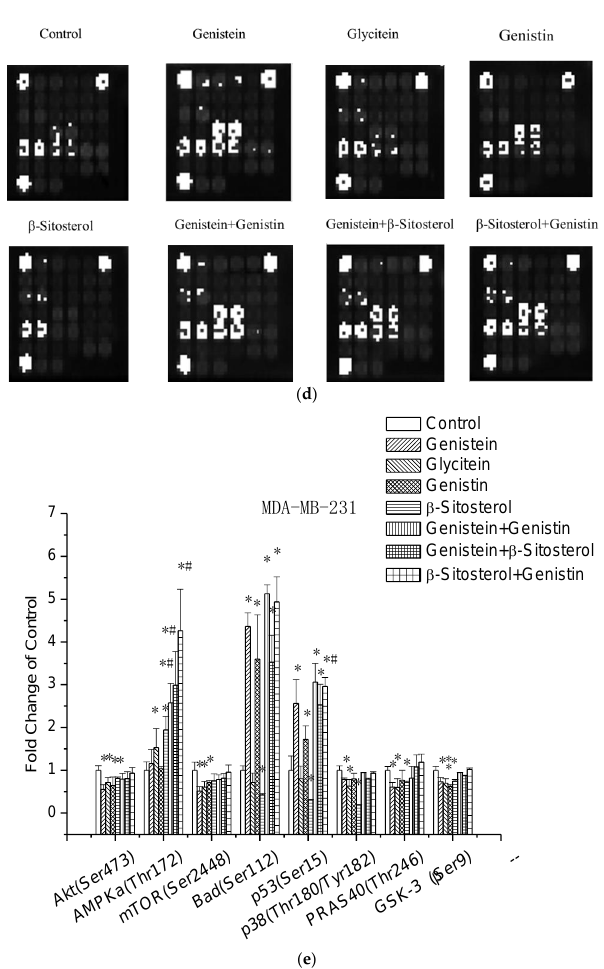
Figure 5. Modulations of intracellular signaling pathways. Cells were treated with samples, or control for 72 h. Total protein was extracted for the analysis. A slide-based antibody array was used for simultaneous detection of 18 signaling molecules ( a ) when phosphorylated or cleaved using a PathScan Intracellular Signaling Array kit. Image ( b ) and quantitative data ( c ) for MCF-7 cells as well as image ( d ) and quantitative ( e ) data for MDA-MB-23 cells were obtained using a LiCor Odyssey imaging system. Data are presented as mean ± SD. * indicates a significant difference compared to the control ( p < 0.05). # indicates a significant difference compared to treatment with samples by single ( p < 0.05).